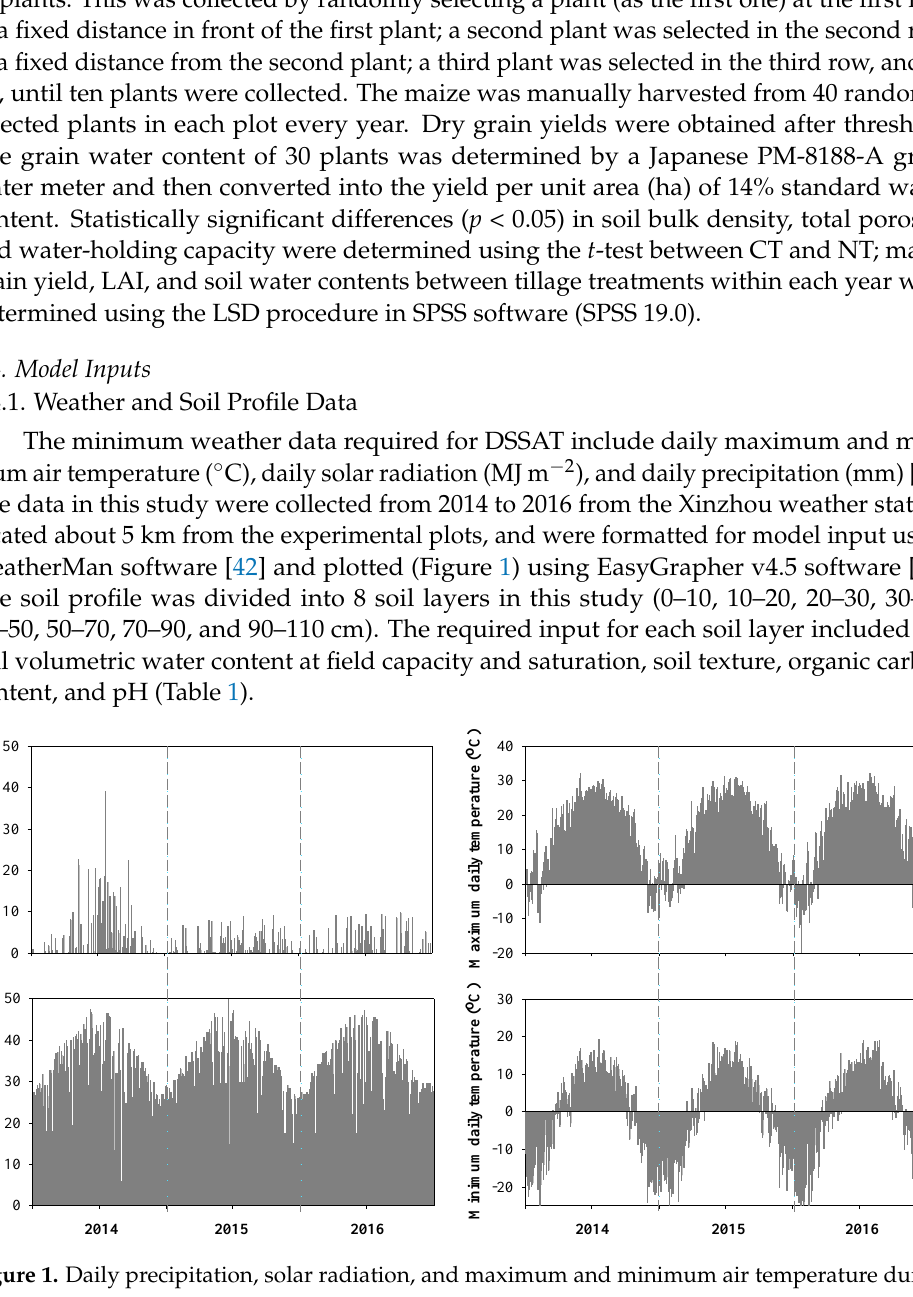
Table 1. Soil profile data collected in 2014 spring and used as initial condition input of the model.